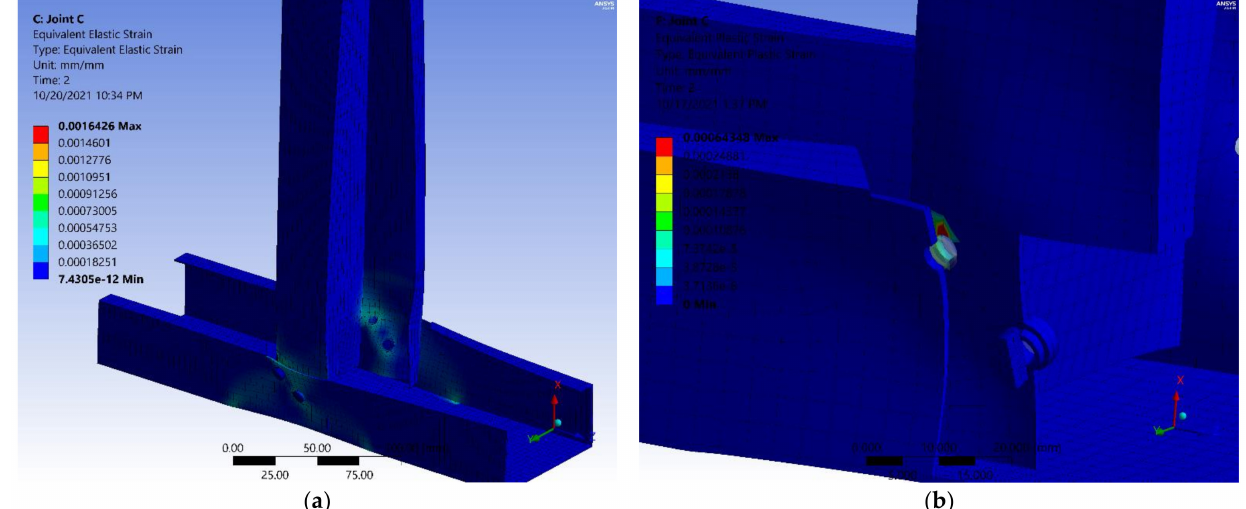
Figure 35. Equivalent strain distribution joint C: ( a ) overall map distribution of equivalent elastic strain; ( b ) detail near hole area of equivalent plastic strain.